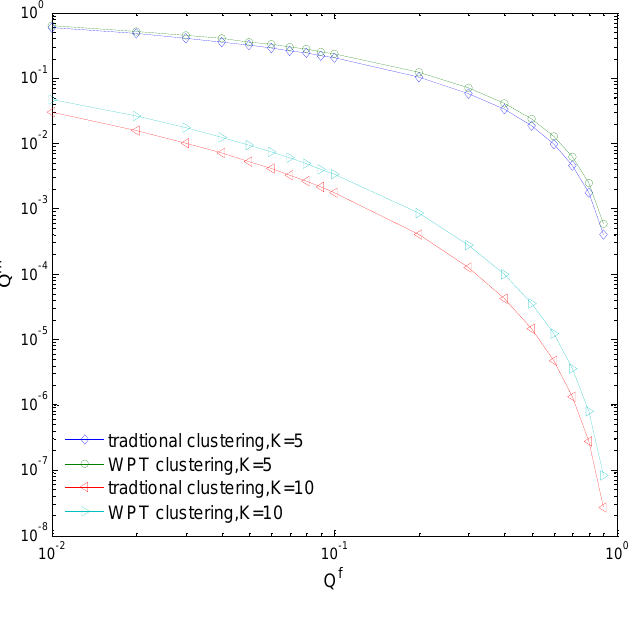
Figure 8. Missed detection